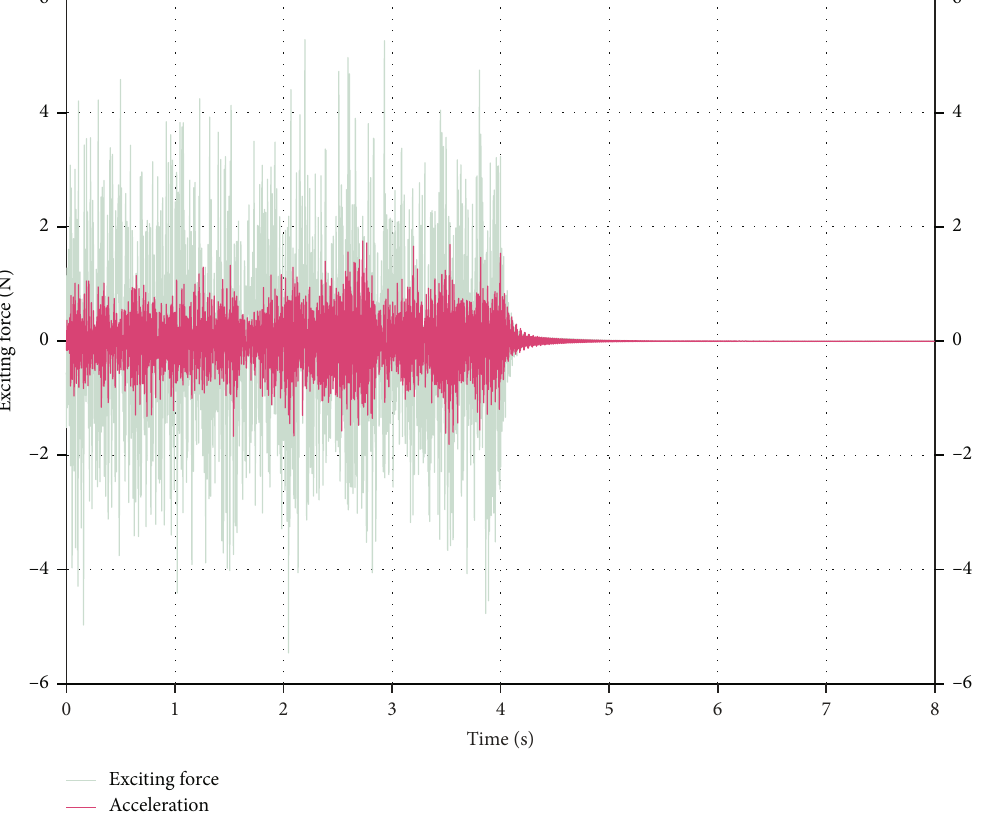
Figure 11: Time-domain signal of ground